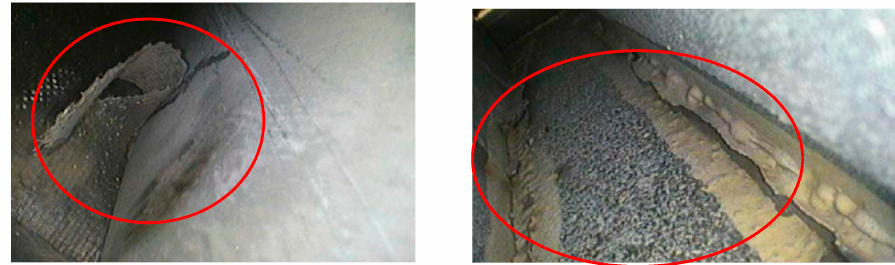
Figure 1. Results from PD activity and electrical stress.